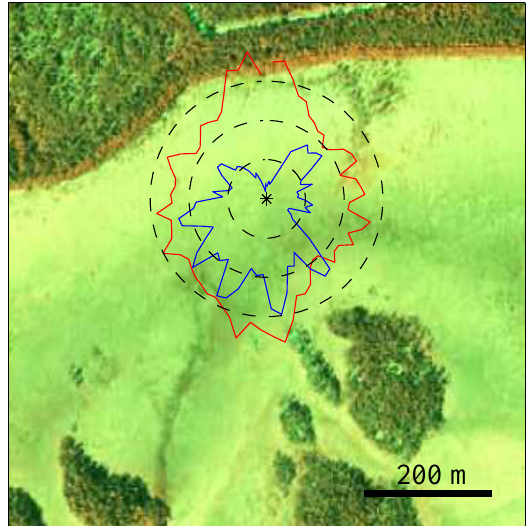
Fig. 1. Aerial photograph of the measurement site. Light green area shows area governed by the fen and the darker green area represents the surrounding forest. Star marks location of the measurement tower, red and blue lines show average methane flux and amount of obtained methane flux data as a function of wind direction, respec- tively. Methane flux is in units mgm − 2 h − 1 and dashed lines show where methane flux equals 1, 2 and 3mgm − 2 h − 1 and amount of data equals 60, 120 and 180 points. Data obtained from RMT-200 was used in this